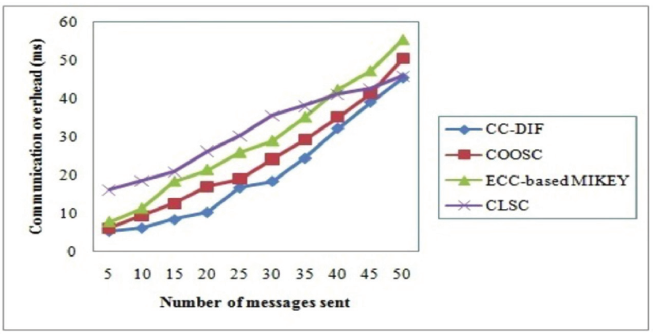
Fig 5. Communication overhead of CC-DIF and three existing